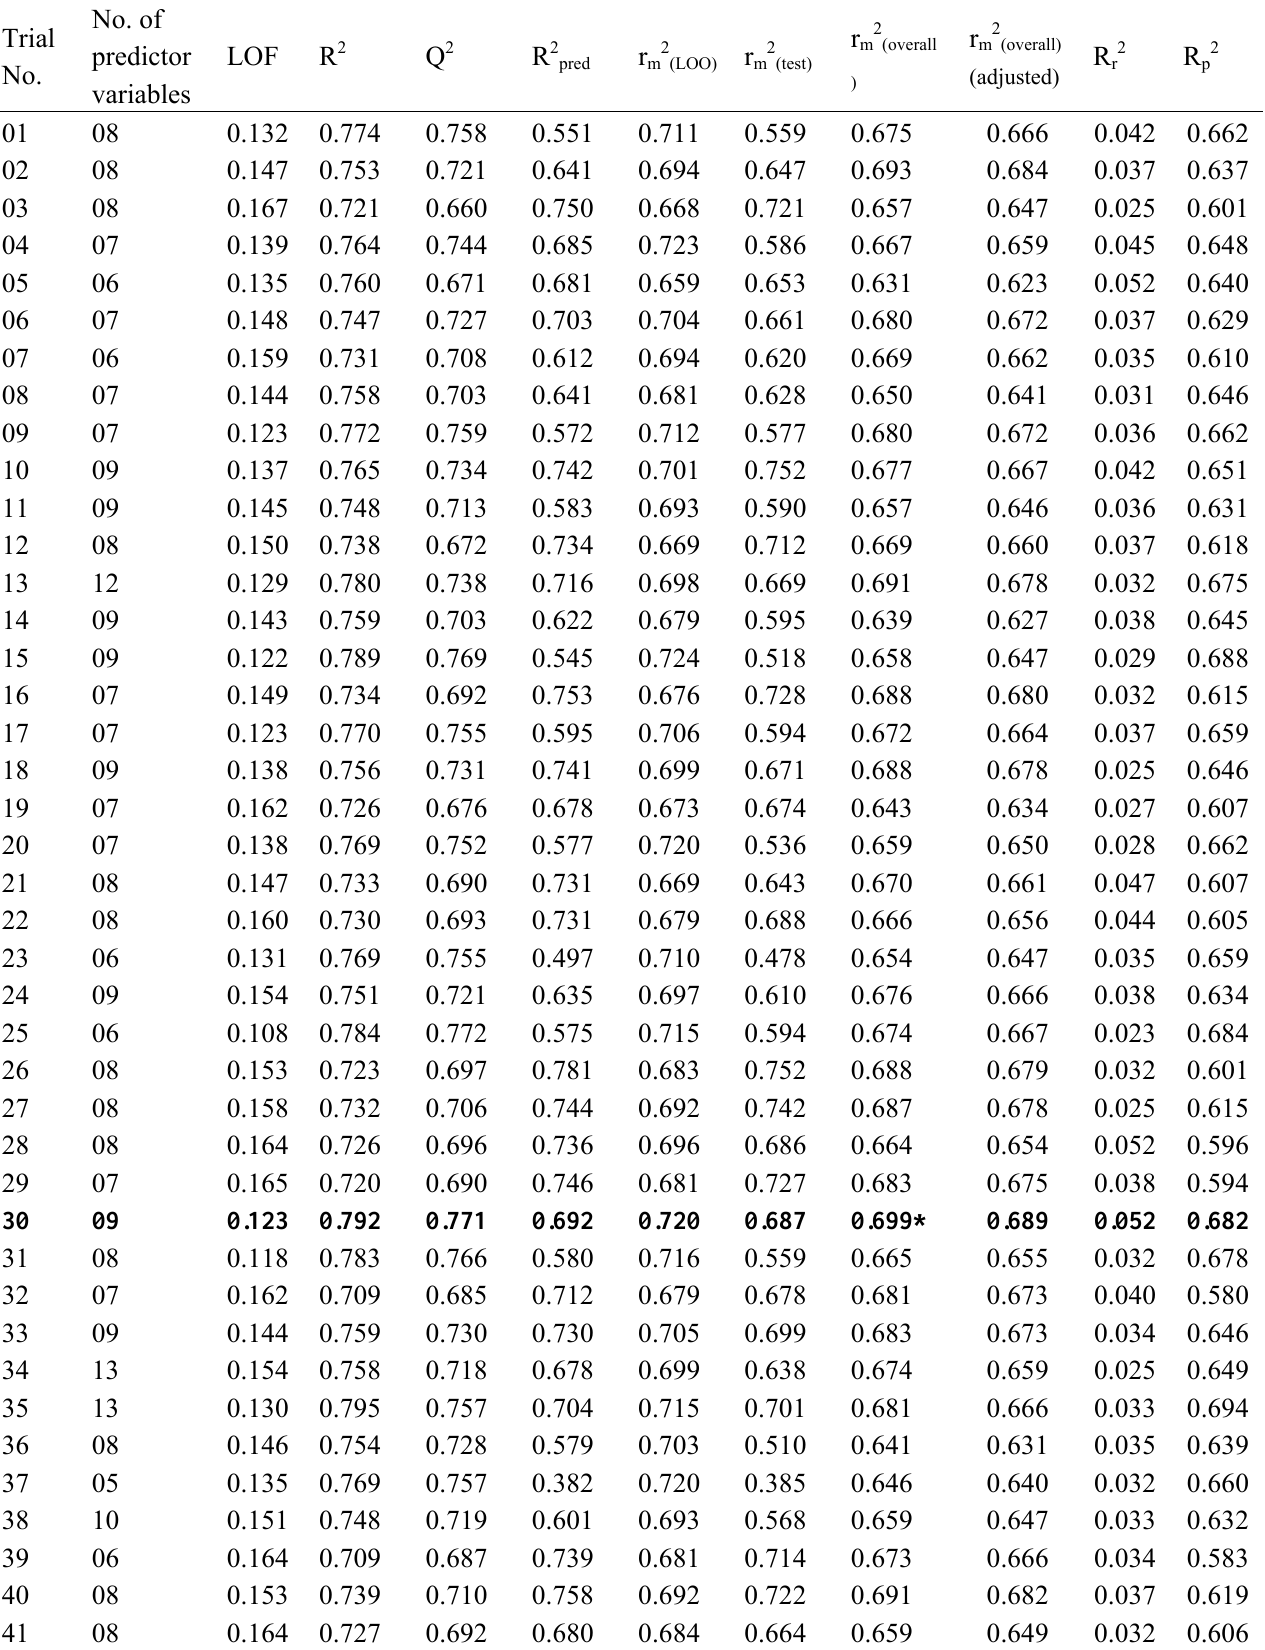
Table 6. Comparison of statistical qualities and validation parameters of different models (Data set